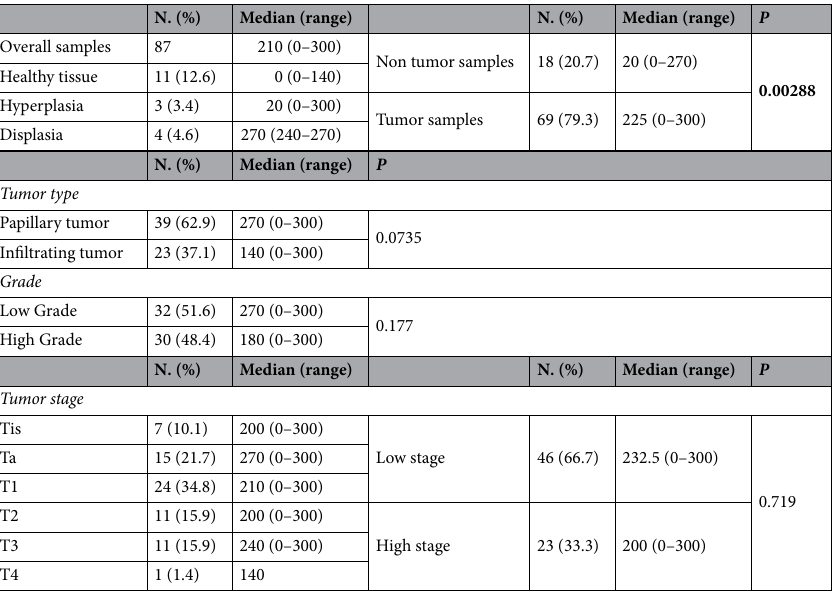
Table 1. PSMA expression (H-score*) in neovasculature of bladder tissue samples. *H-score: the product of the percentage of the immunopositive tumor cells and the staining intensity. Tis: in situ. No. 69 total tumors: 62 “tumors classified by tumor-type/grade” and 7 “in-situ